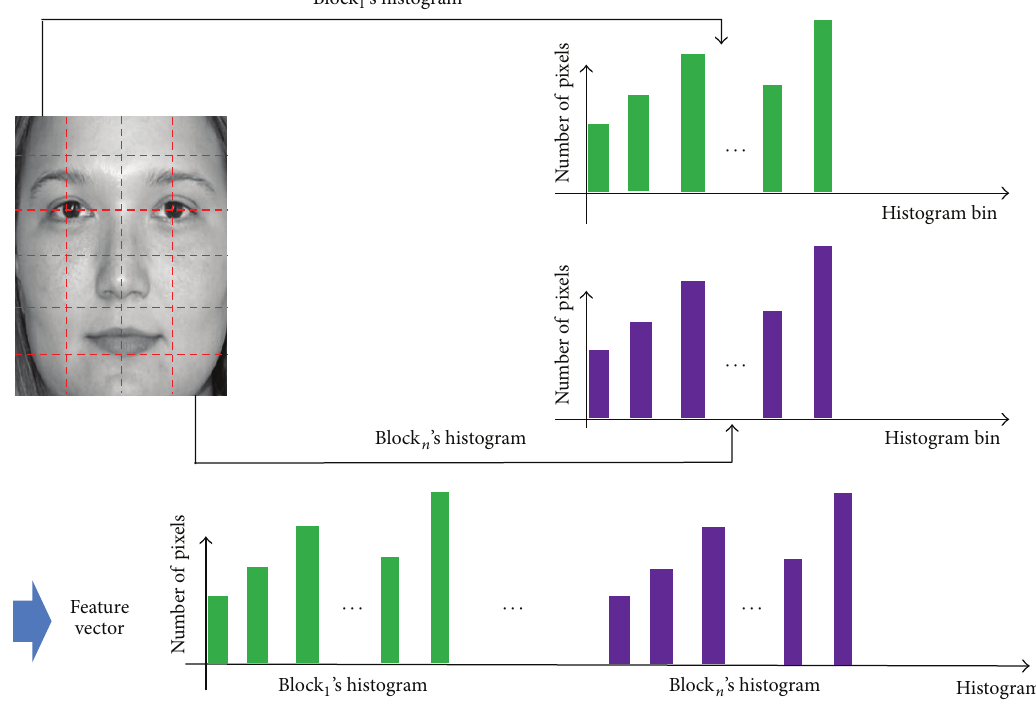
Figure 8: Method for constructing the LBP feature vector from multiple subblocks.